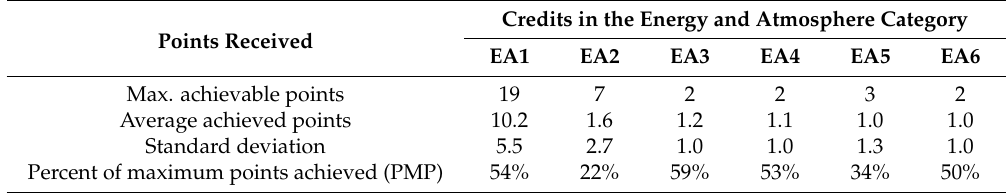
Table 3. Descriptive statistics of Energy and Atmosphere credits in LEED-NC 2009-certified buildings in the